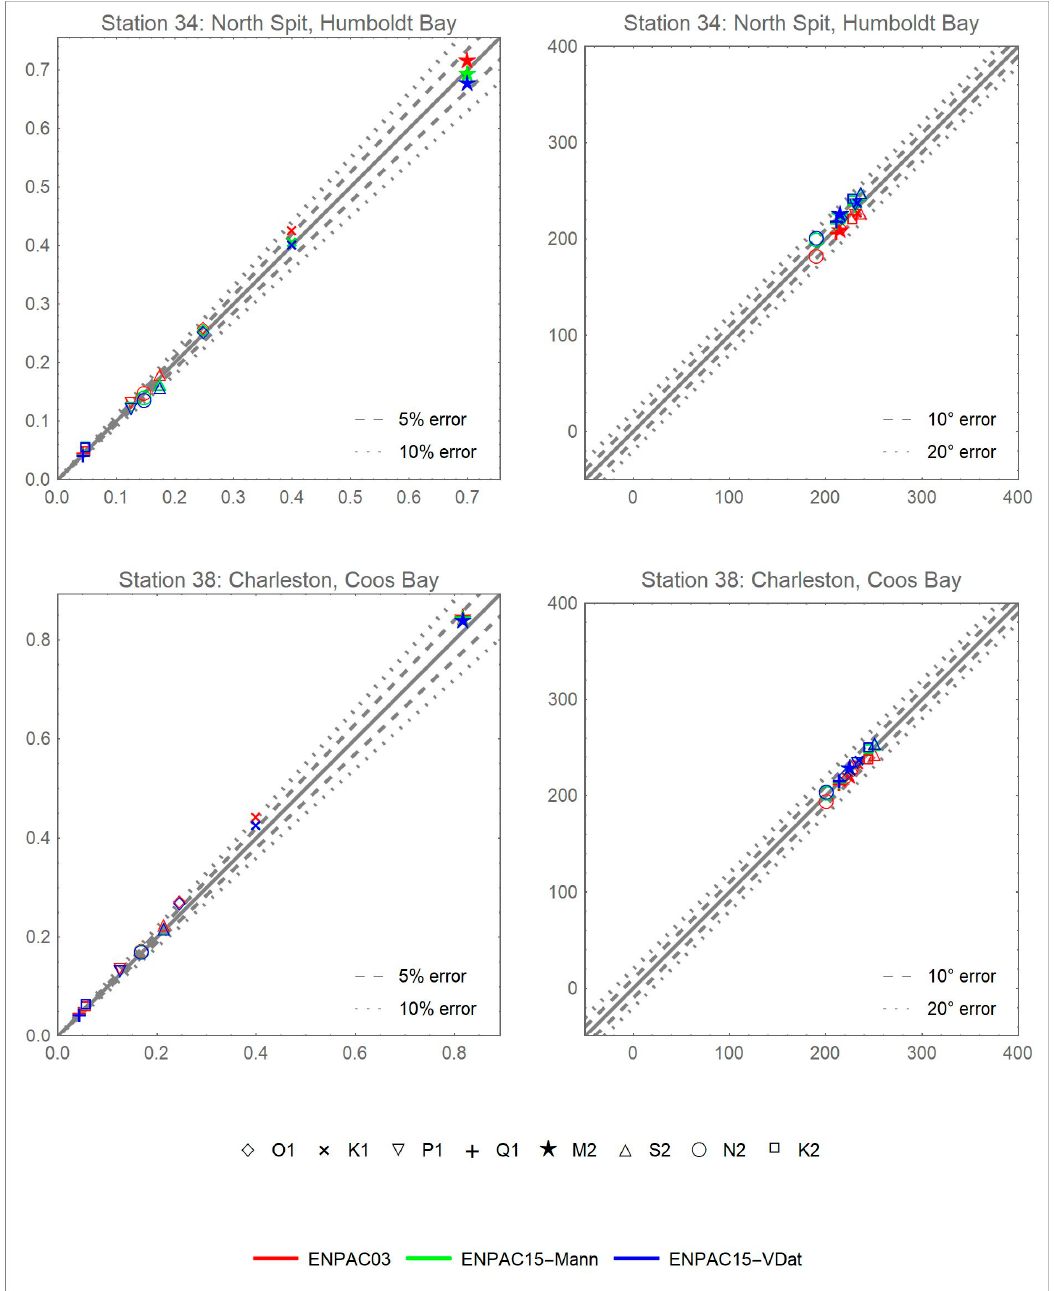
Figure A8. Scatterplots of errors for two Northern California stations, locations shown in Figure A2.